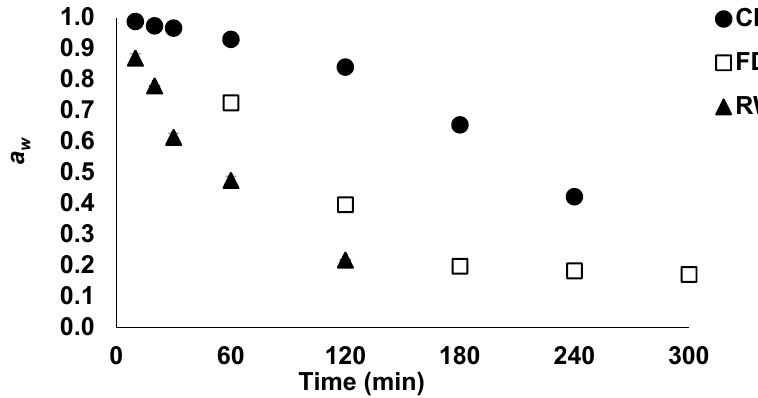
ff ect of the drying method (CD, FD and RW) on the water activity of guava Figure 4. Effect of the drying method (CD, FD and RW) on the water activity of guava samples. Figure 4. E